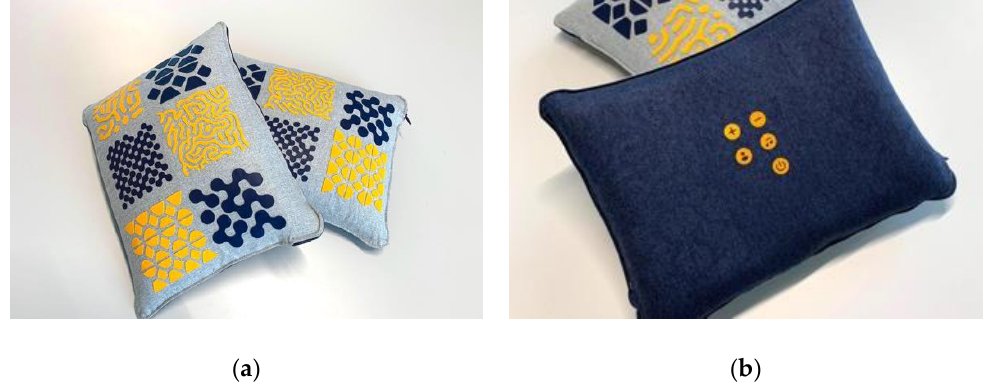
Figure 1. Vita served as an example of audio-based technology: ( a ) Vita is a cushion with conductive touchpads to play audio content and ( b ) with buttons on the reverse side to adjust the settings or volume.